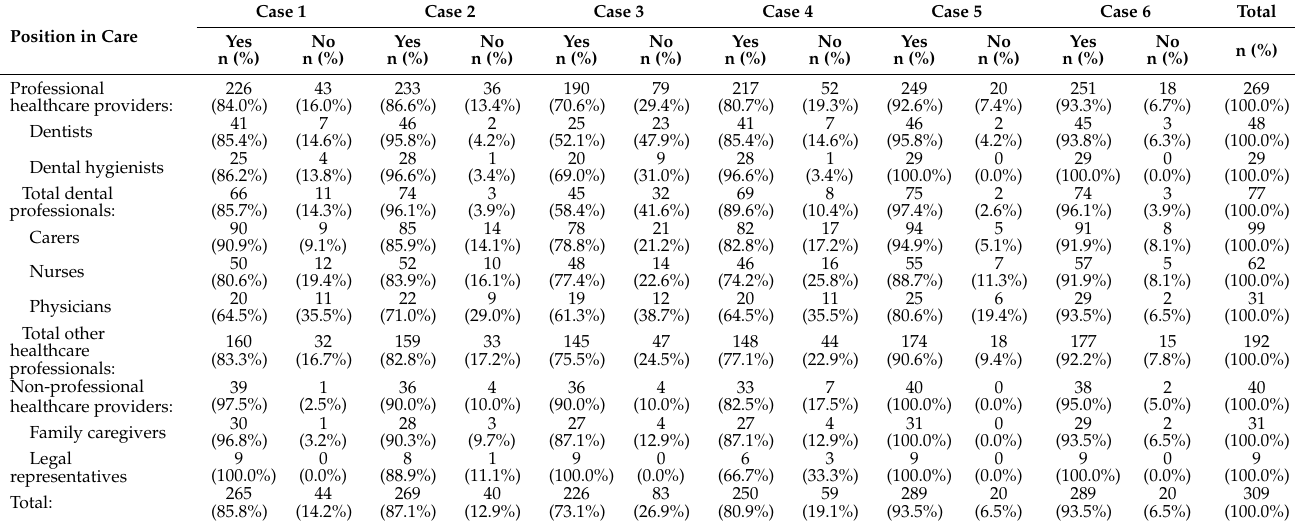
Table 2. Participants’ responses to the assessment of harmfulness (Question 1) of Cases 1 to 6.